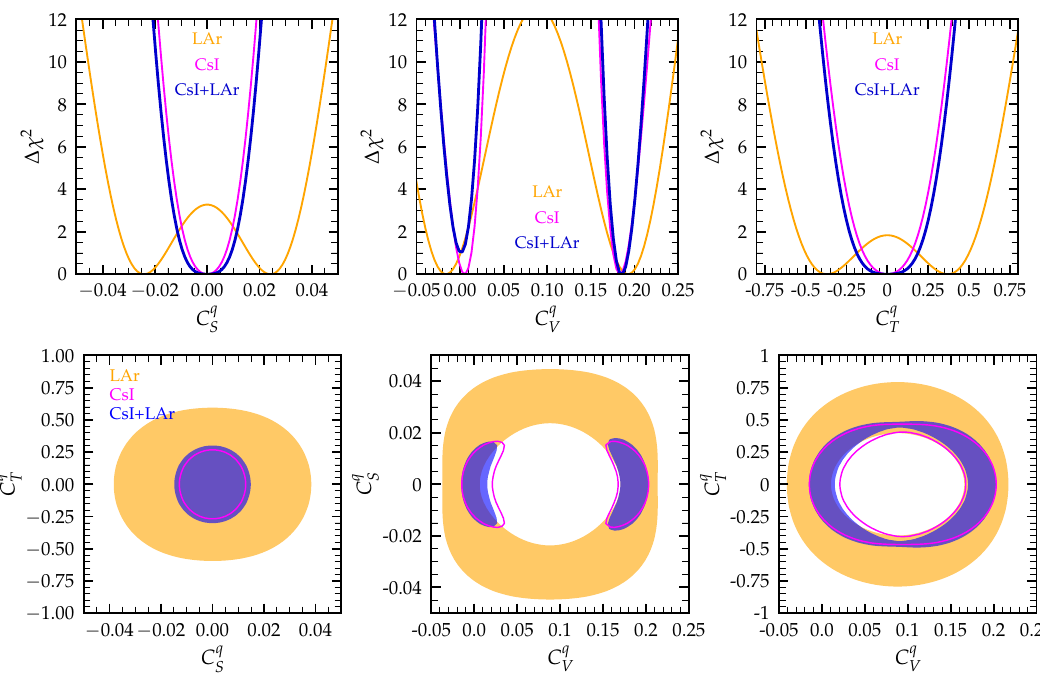
Figure 7 . Upper panels: ∆ χ 2 profiles for single NGI from the CsI (magenta), LAr (orange) and CsI + LAr (blue) analyses. The analysis of CsI data includes only CE ν NS interactions. Lower panels: 90% C.L. (2 d.o.f.) allowed regions on neutrino NGI allowing two NGI couplings at a time.